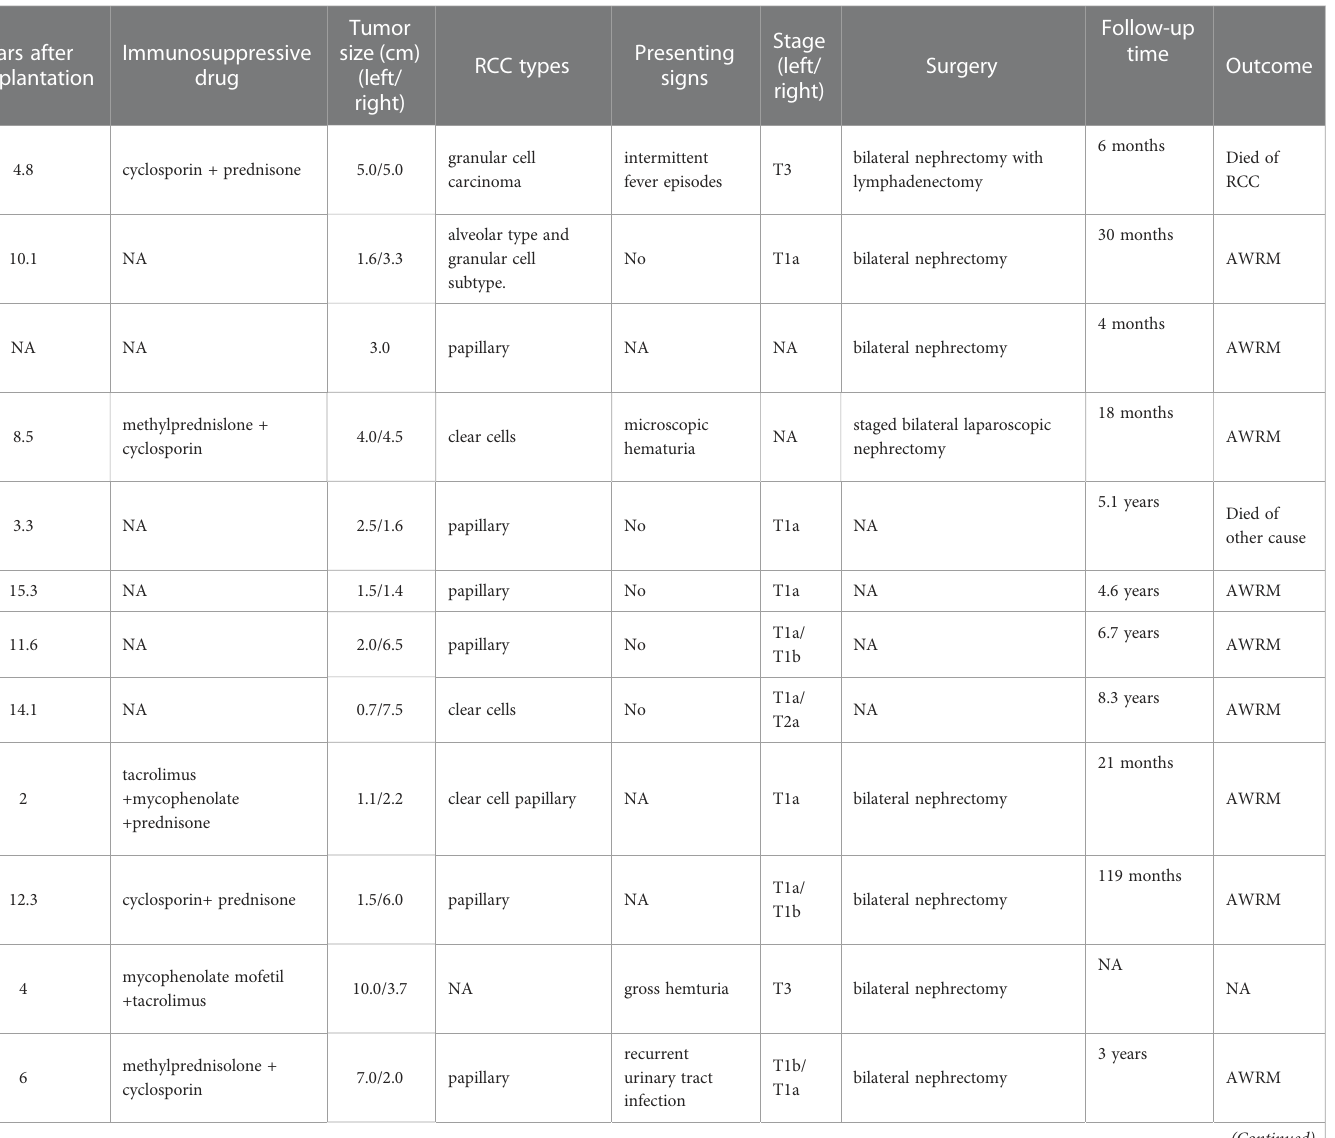
TABLE 1 Published cases developing renal cell carcinoma in bilateral native kidneys after kidney